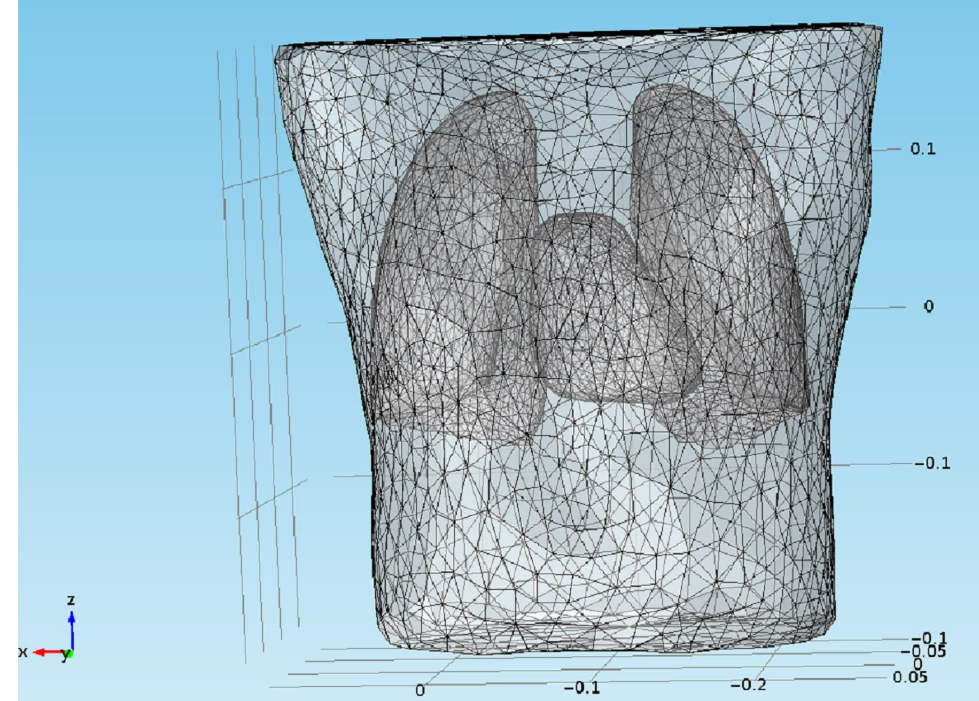
Figure 2. Developed FEM model used in the